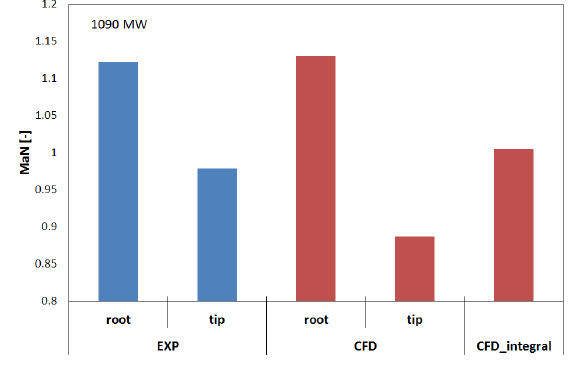
Figure 14. Nozzle Mach number.